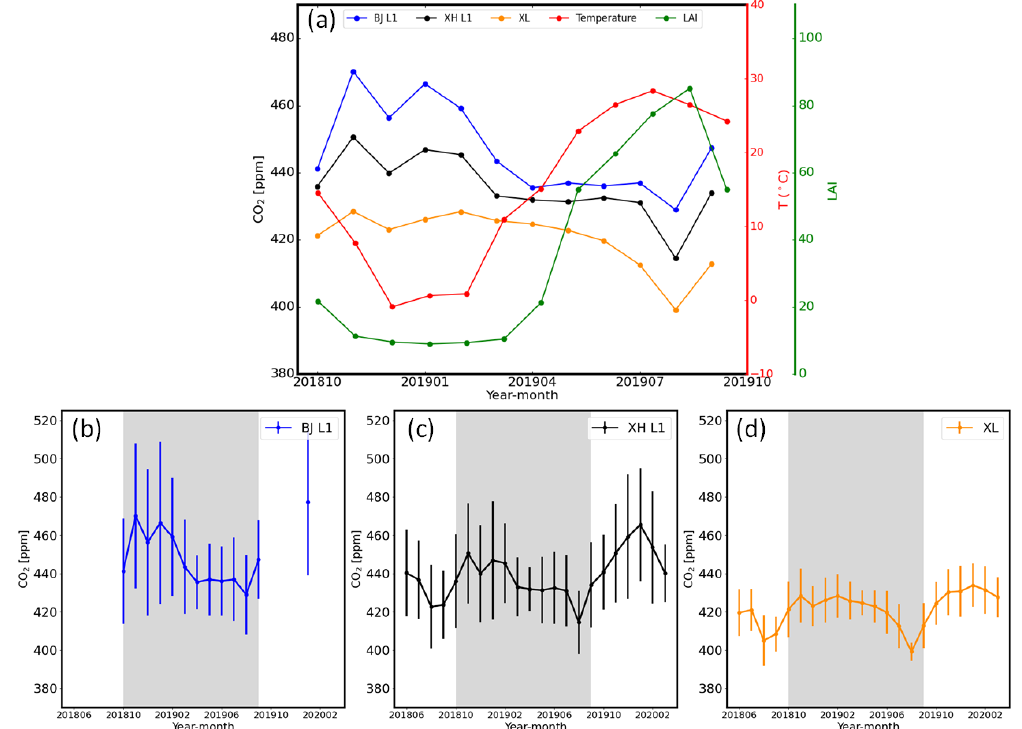
Figure 8. (a) The monthly means of CO 2 at BJ L1, XH L1, and XL between October 2018 and September 2019. The monthly mean air temperature at BJ and regional mean leaf area index (LAI) of the area in Fig. 1a during the same period are also displayed. (b–d) Monthly means of CO 2 together with the 1 σ standard deviation at BJ L1, XH L1, and XL between June 2018 and February 2020. The gap at BJ L1 is due to the instrument failure. The shaded area is the measurement period displayed in Fig.